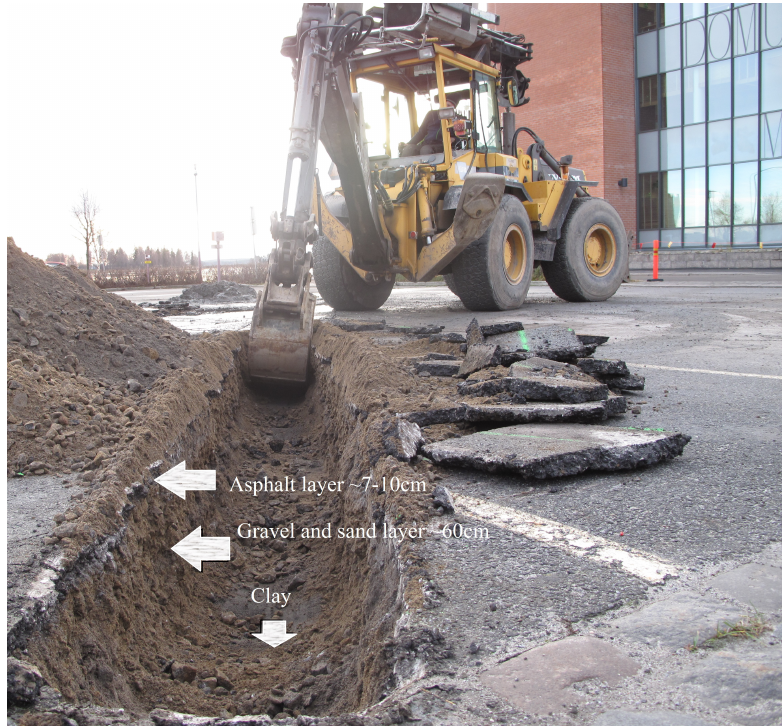
Figure 5. Soil layers under the asphalt in the measurement field at the University of Vaasa campus